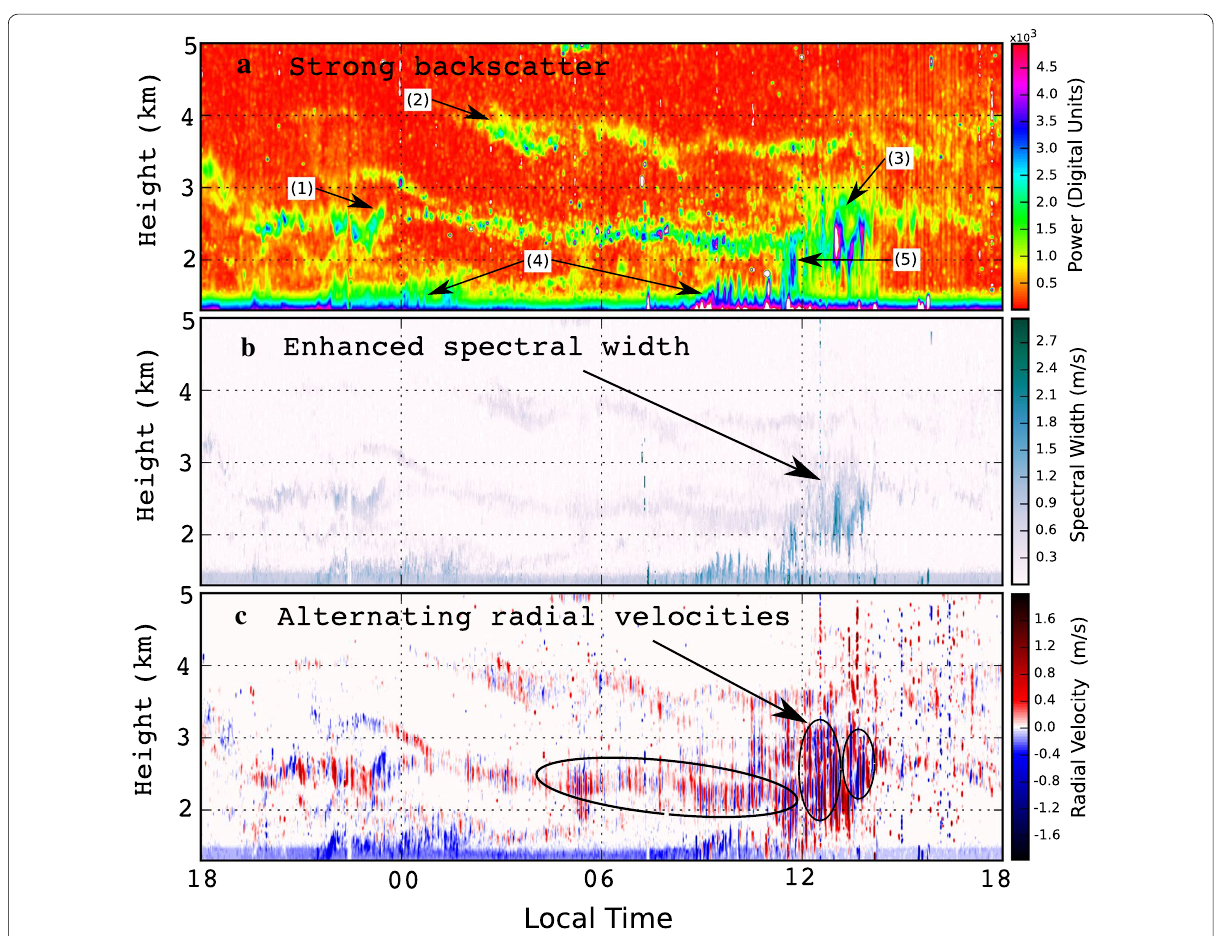
Fig. 1 Radar product used for analysis. Information obtained by Gaussian fitting to the Doppler spectra. Shown are a integrated power, b spectral width, and c radial velocity for April 13th, 2014. This type of product was generated for each day and used to categorize and classify the atmospheric echoes by recognizing various different characteristics and their associated time